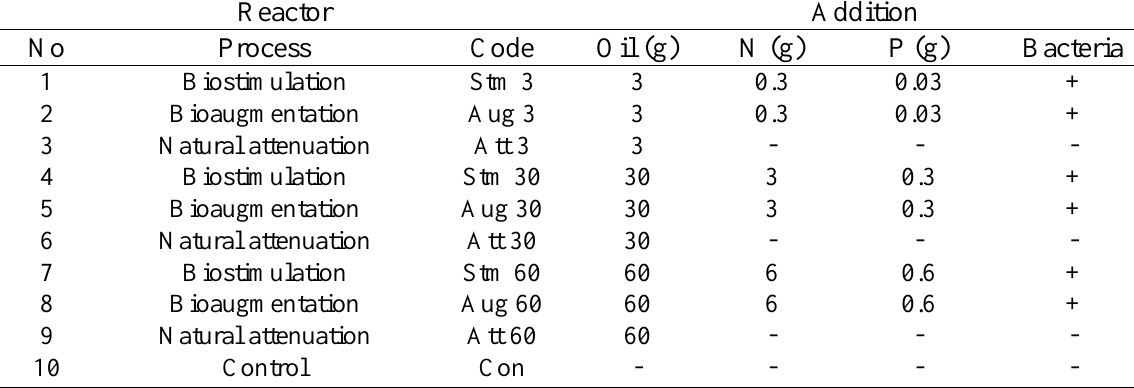
Table 4. Reactors and conditions for bioremediation